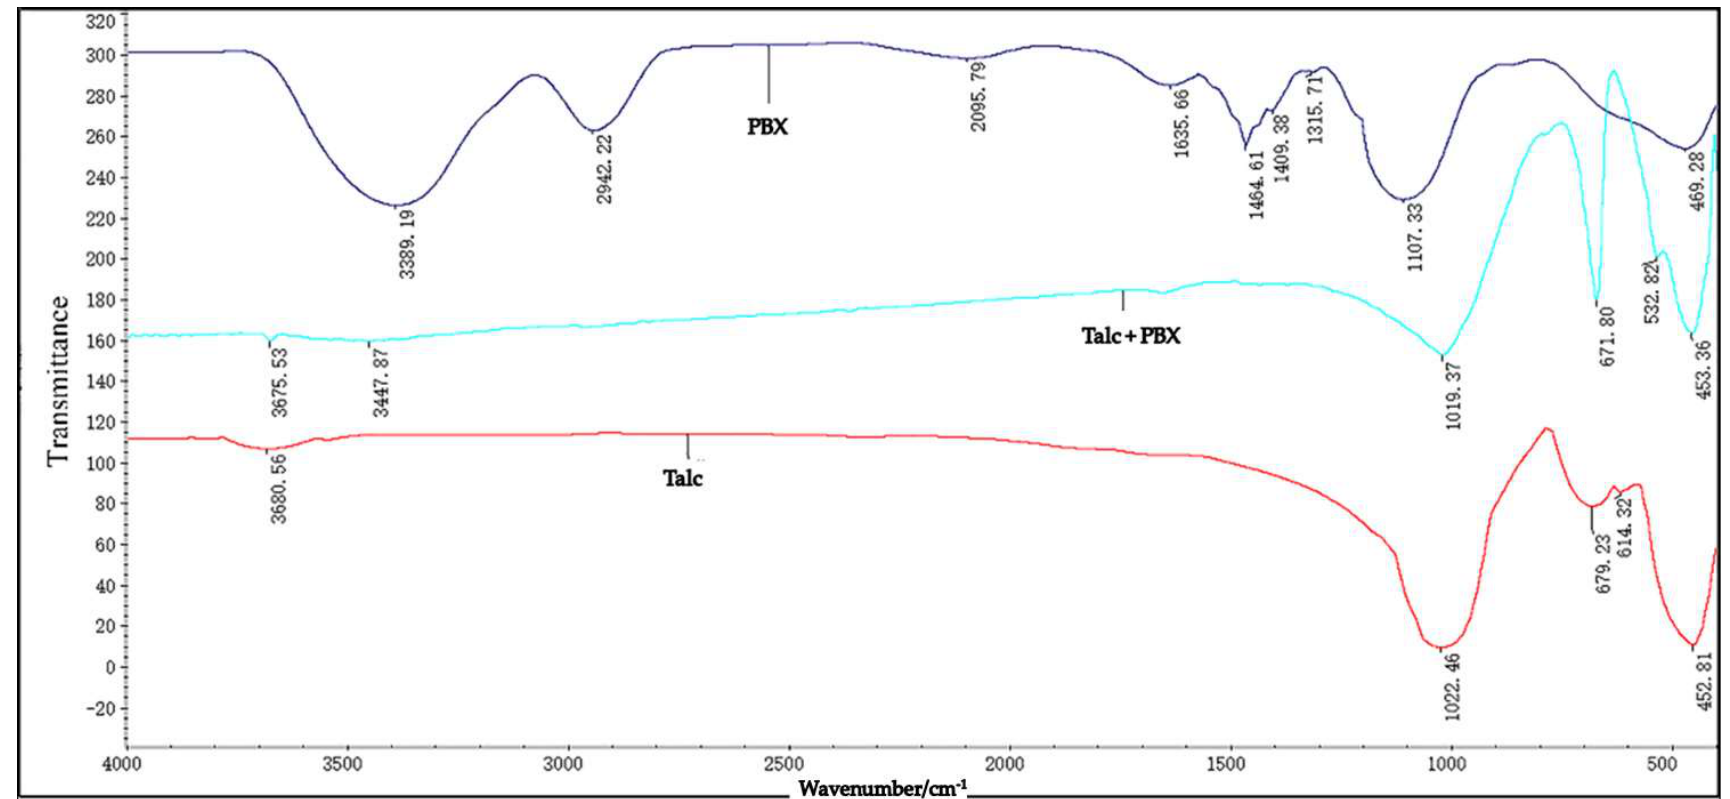
Figure 6. Infrared spectra of talc before and after treatment with PBX.